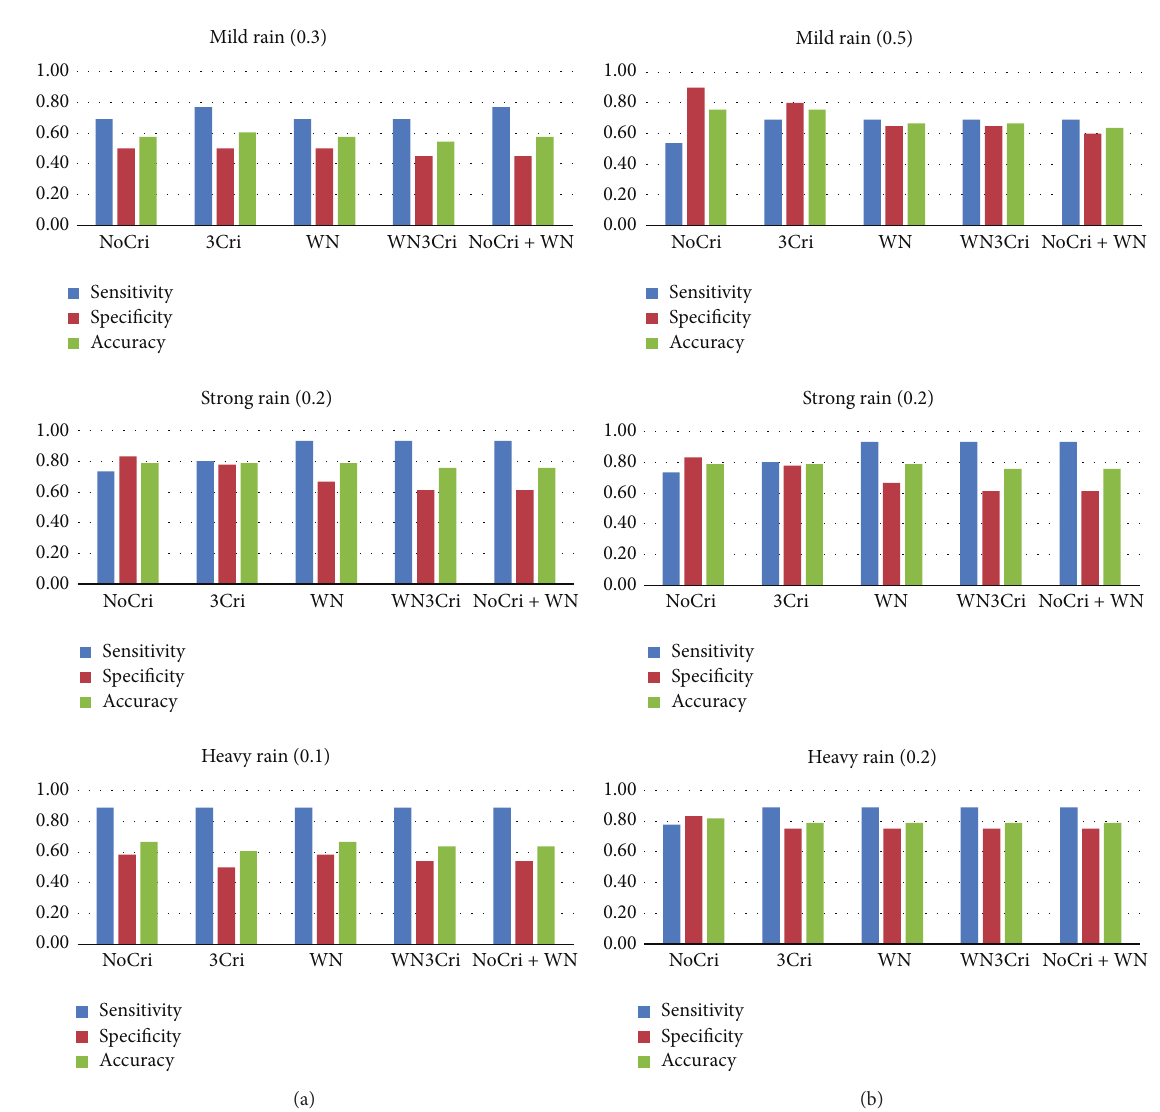
Figure 8: Validation results for specific flood events. The first column is for the probability thresholds (in parenthesis) found to have the best validation results in Figure 7 (global thresholds) and the second column is for the thresholds having the best validation results for the specific flood